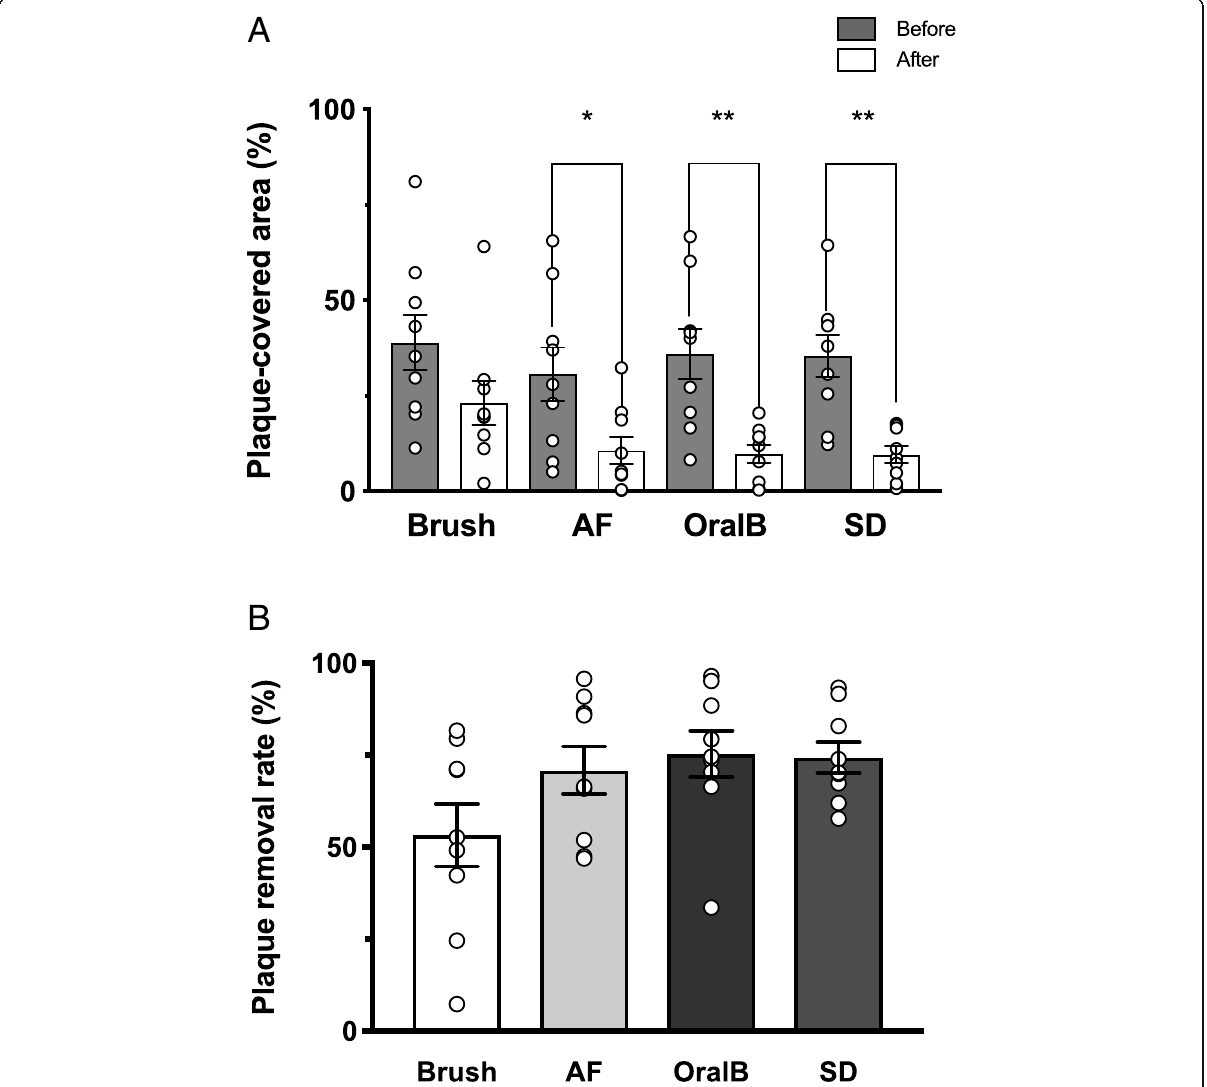
Fig. 2 Plaque areas before and after brushing and plaque removal rates. a All brushing instruments except for the manual toothbrush showed significant reduction of accumulated plaque in the fitting surfaces of implant-supported fixed dental prostheses. Note that the plaque areas before brushing did not differ significantly among the four instruments based on multiple comparison statistics. b No significant differences in plaque reduction were observed among the four instruments. * p < 0 .05; ** p <